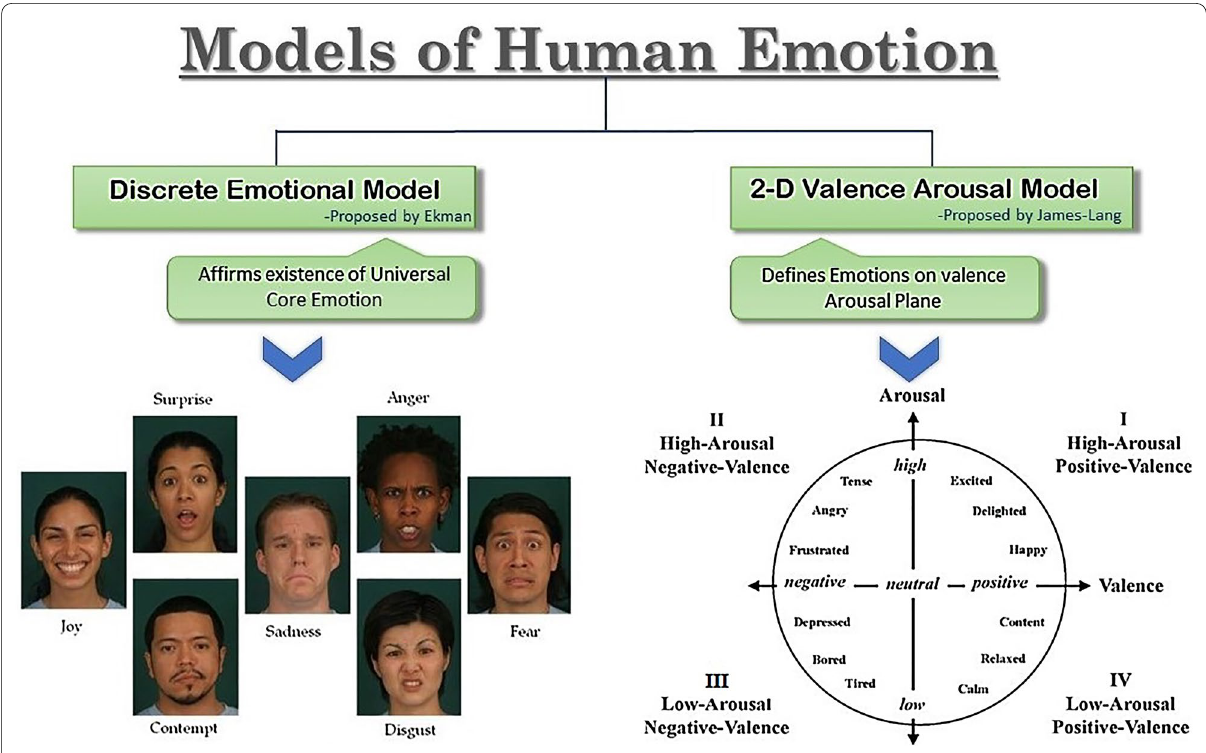
Fig. 2 Models of human emotion widely used in emotion